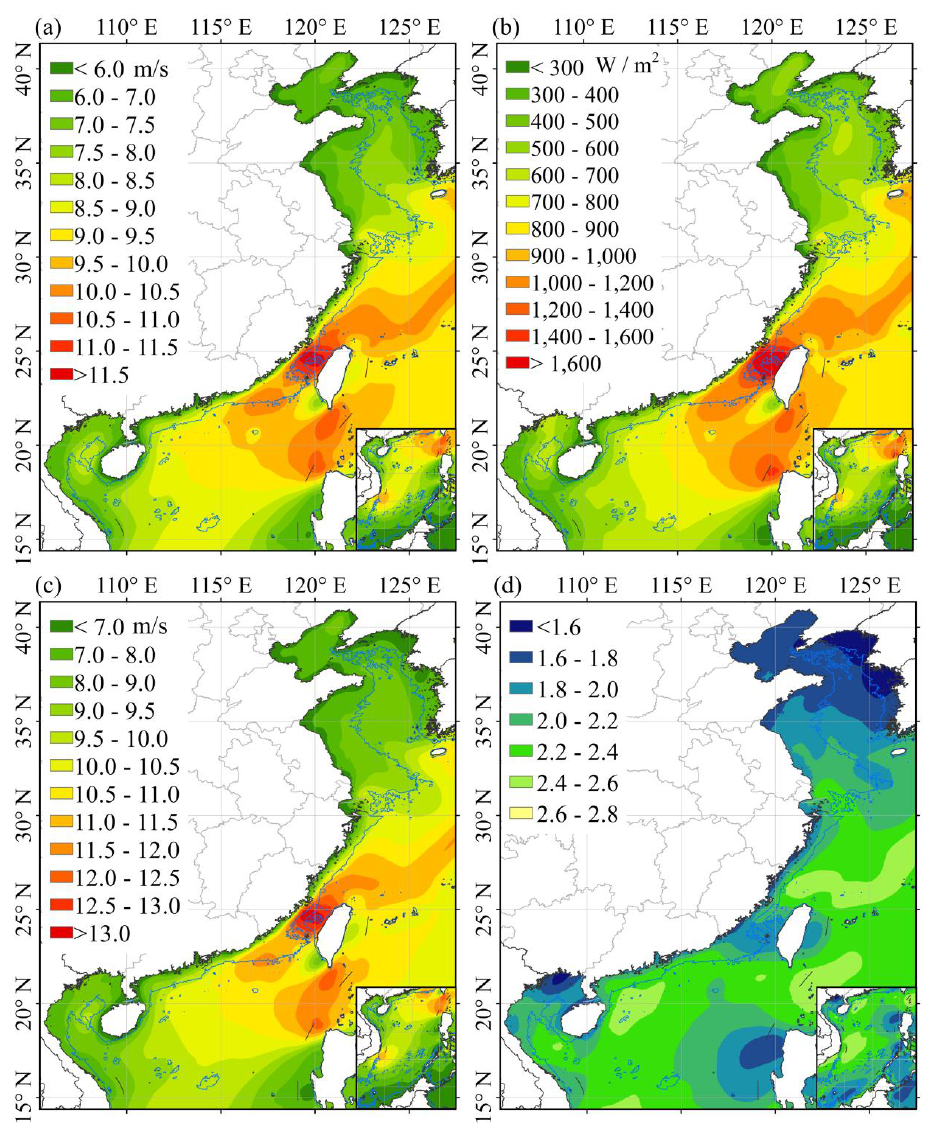
Figure 4. The geographic distribution of interpolated MWS, WPD, and Weibull parameters at 100 m above sea level using OCK method with a spatial resolution of 0.01° × 0.01° over the China Sea (the blue line indicates water depth at 50 m). ( a ) interpolated MWS, ( b ) interpolated WPD, ( c ) interpolated Weibull C, and ( d ) interpolated Weibull k.